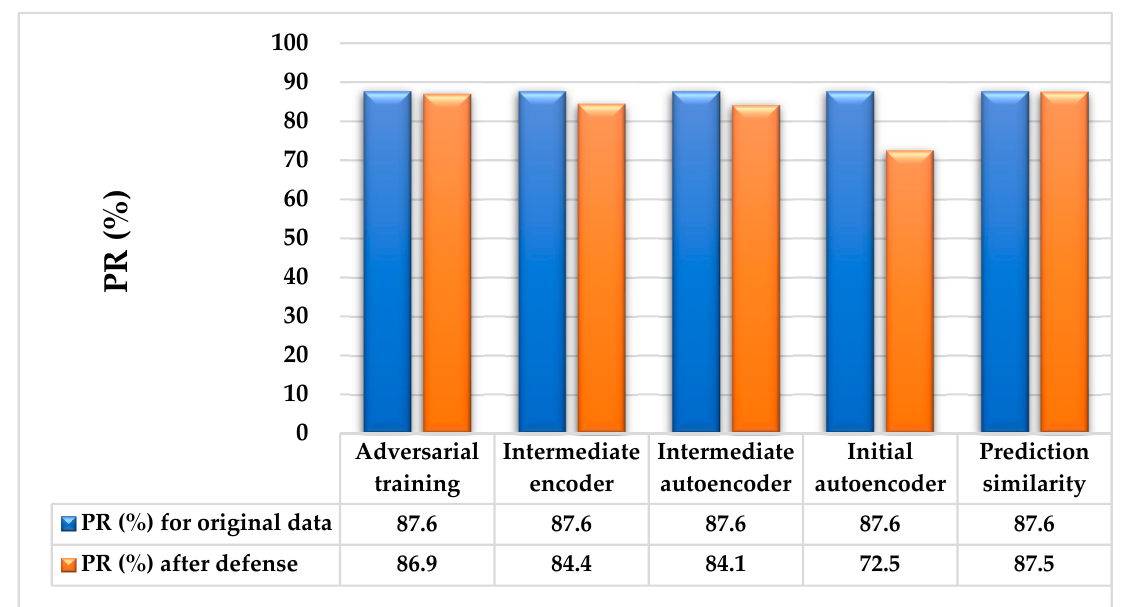
Figure 14. PR comparison between defense models and original model.